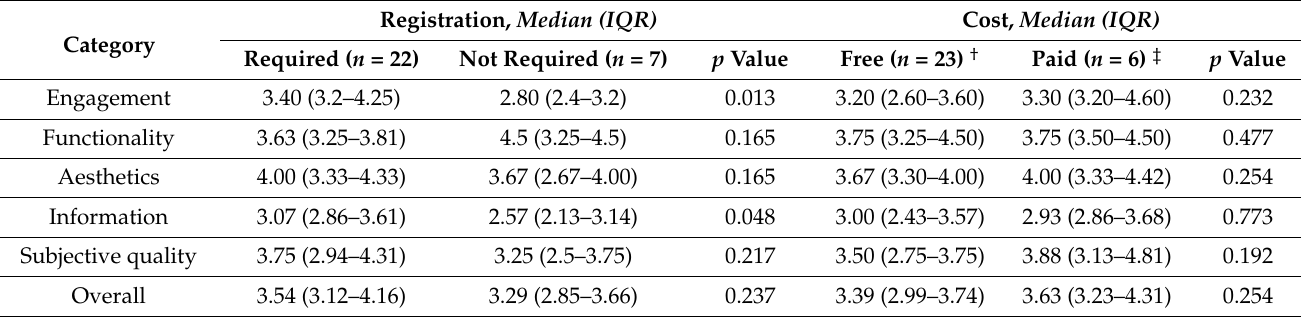
Table 4. Quality comparison by different